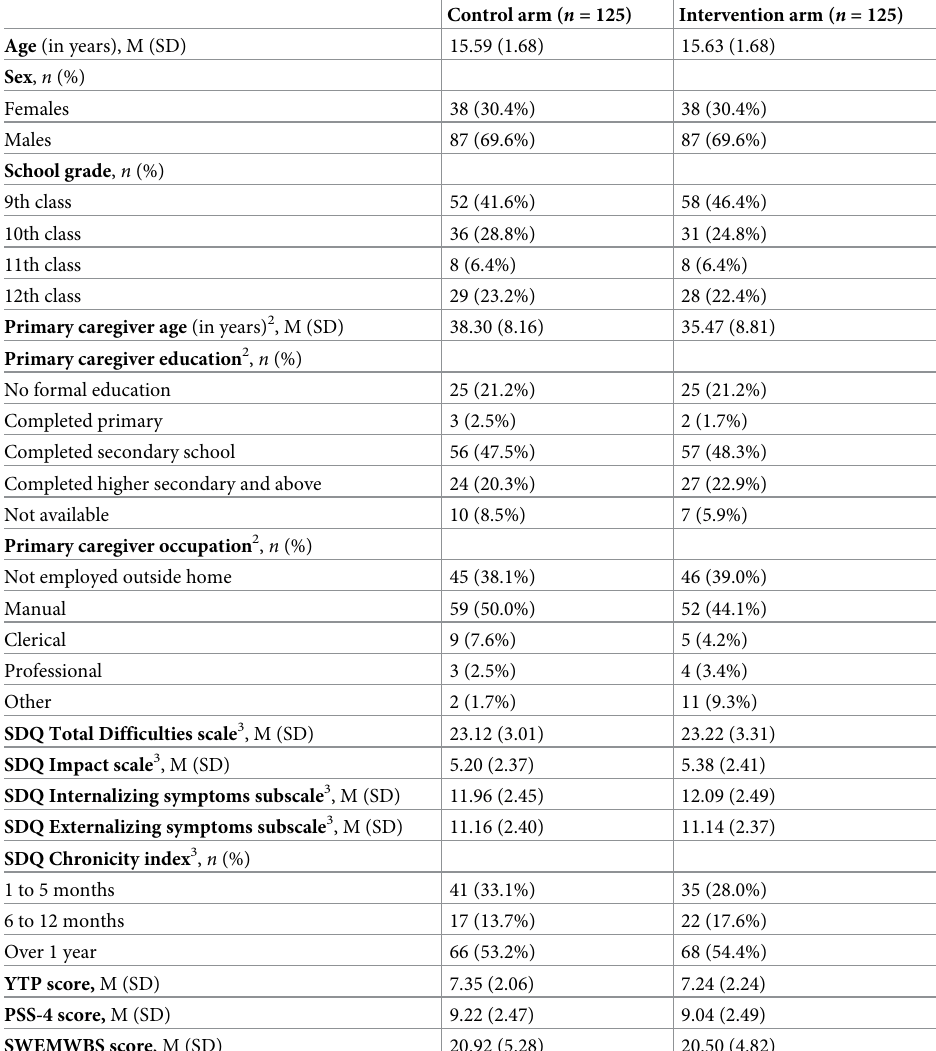
Table 1. Baseline characteristics of participants 1